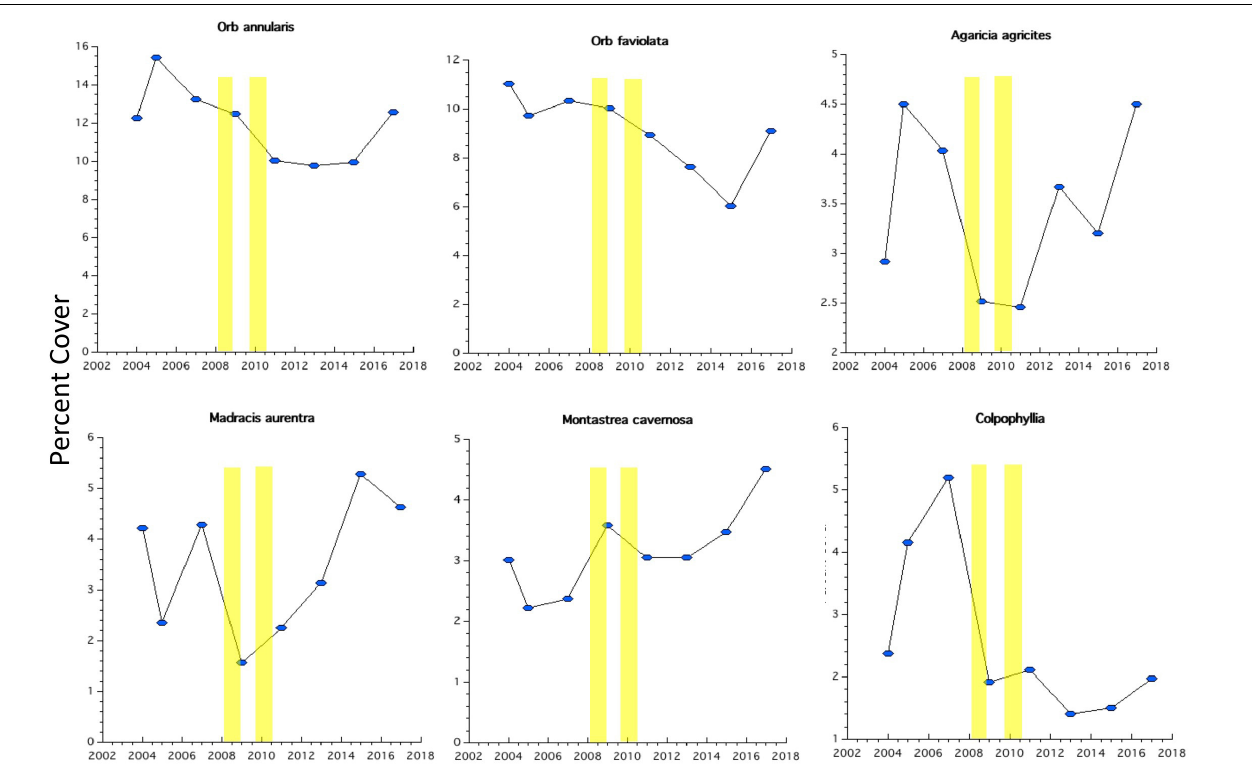
FIGURE 6 | Abundance trajectories of the six most abundant coral species since 2004. Vertical yellow bars denote the timing of Hurricane Omar and the 2010 coral bleaching event.